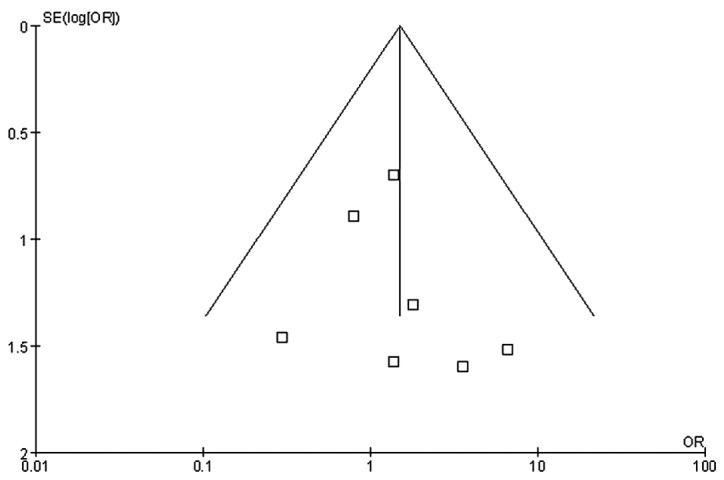
Funnel plot of comparison: local recurrence of limb salvage vs. amputation on treating osteosarcoma in patients with pathological fracture.